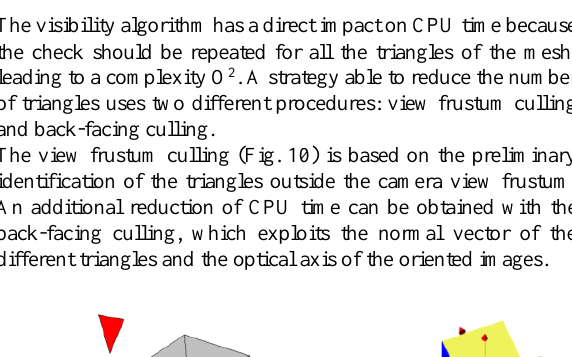
Fig. 9. The flowchart for true-orthophoto generation.